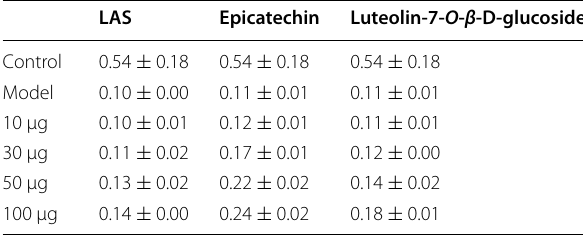
Experiments were performed with 3 different batches of cells and each batch was tested in triplicate. The Fenton reagent (FeCl 2 plus H 2 O 2 ) was used to generate •OH radicals. These data represent the mean vs.